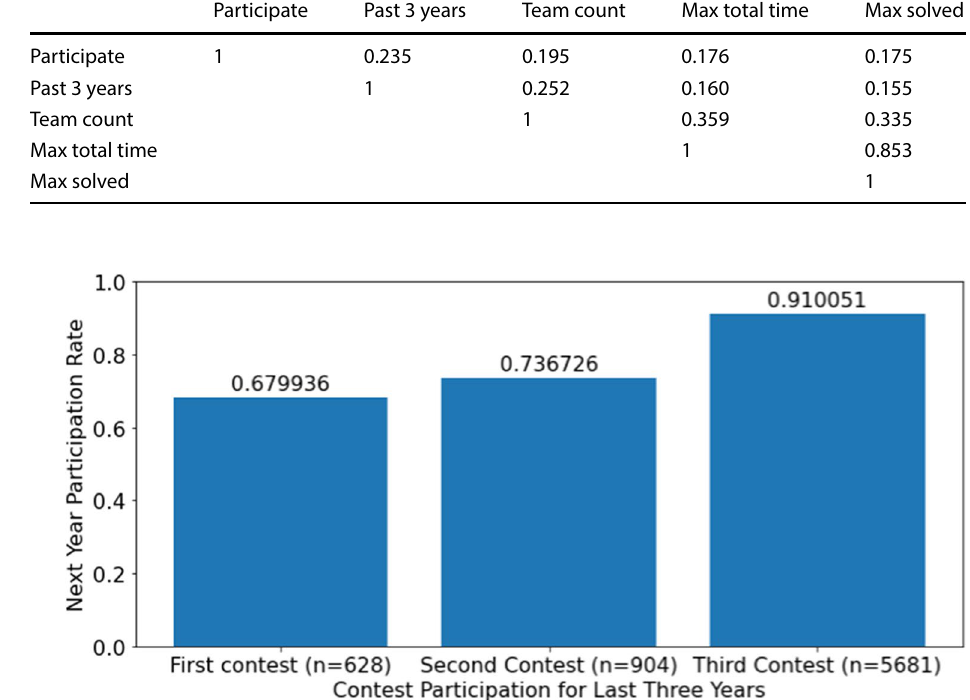
Table 3 Attributes with largest correlation with